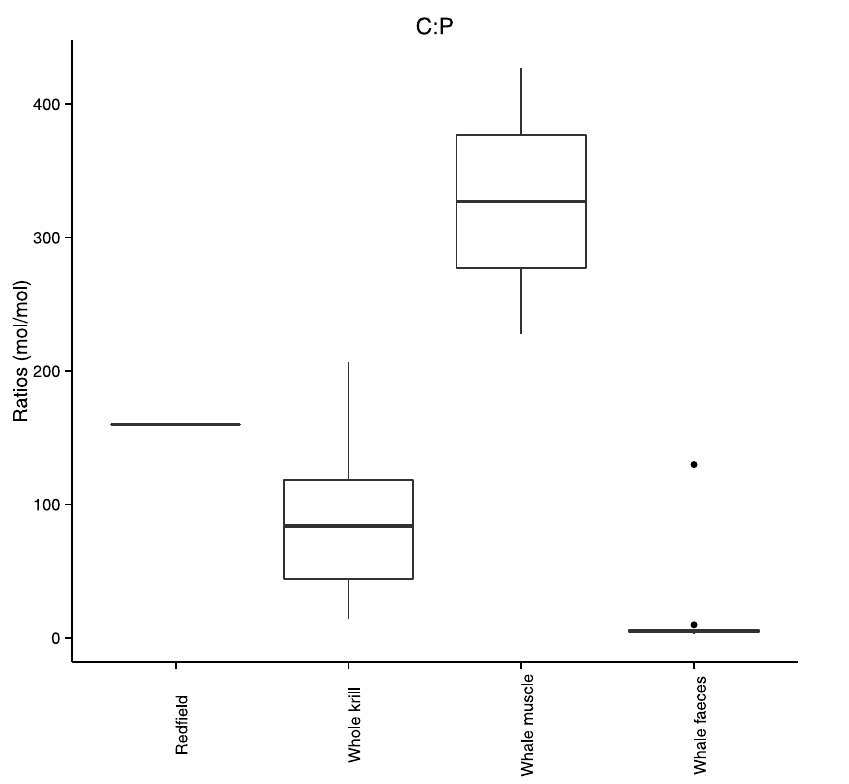
Figure 2. Carbon to phosphorus ratio in krill and whales (mol mol 2 1 ). Data point above the third quartile for whale faeces is 3 or more times higher than the interquartile